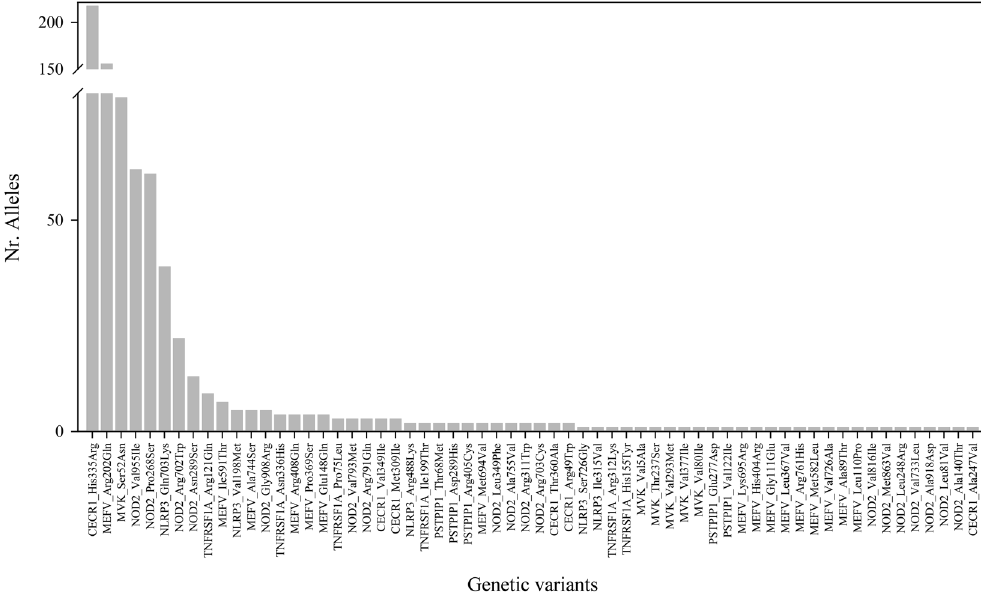
Figure 1. Graphical representation of the number of alleles (y-axis) of each variant detected (listed in x-axis and ordered according to the number of alleles found) in our Behçet disease patient